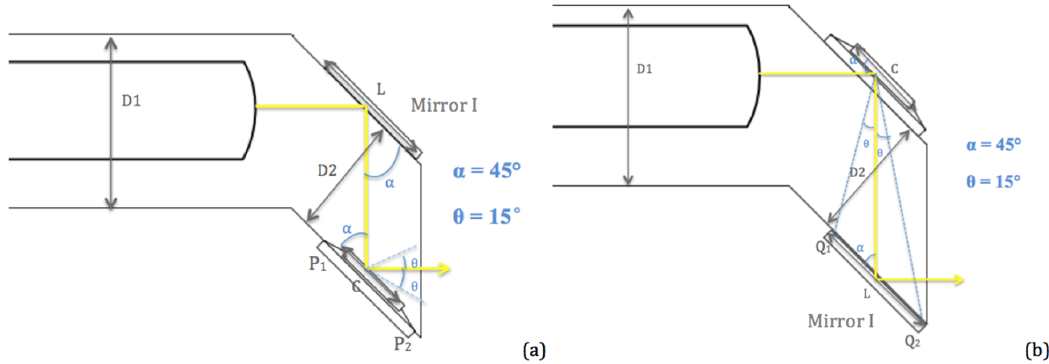
Figure 7. Top view of the MEMS chip structure. ( a ) A structural design with the beam folding mirror as the first incident mirror. ( b ) A structural design with scanning mirror as the first incident mirror. The base plate for the optical fiber and the GRIN lens was a 0.5 mm-thick SOI wafer. The width